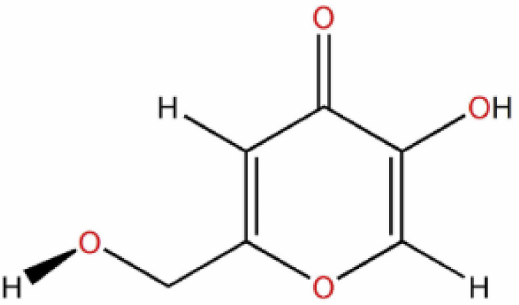
Figure 1. Kojic acid chemical structure, Adapted with permission from Ref. [6], 2020, Hasil et al. The crystals of KA are acicular and colorless, and they sublime in a vacuum with no variations. KA is soluble in some organic solvents, such as ethyl acetate, water, and